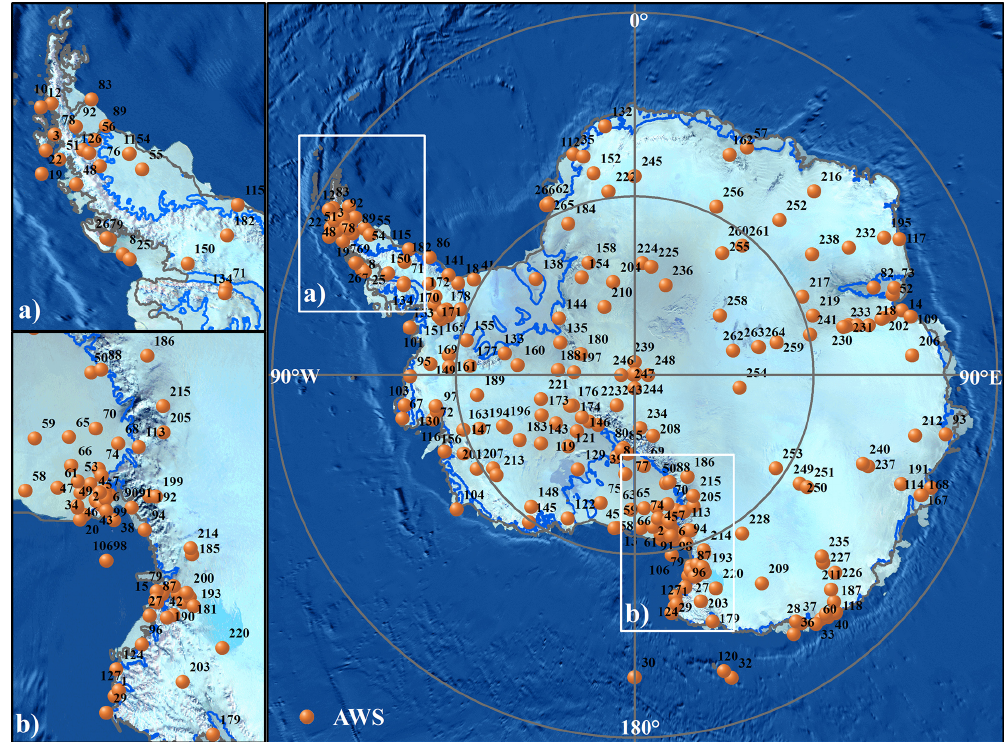
Figure 3. Map of the 267 automatic weather stations (AWSs) in this study, where the numbers (1–267) correspond to “NO.” in Table S1.